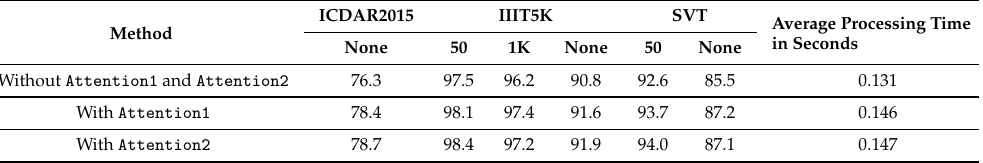
Table 3. Analysis of attention blocks in the proposed text recognition network in different configurations.